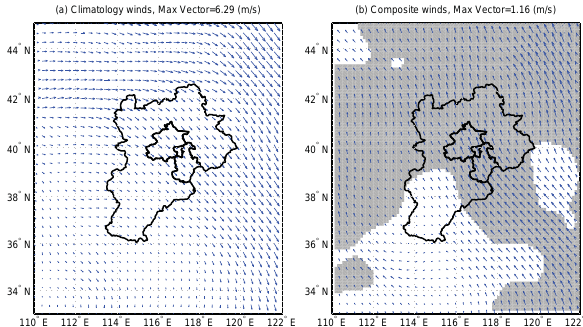
Figure 9. Same as Fig. 7 but for vertical speed.